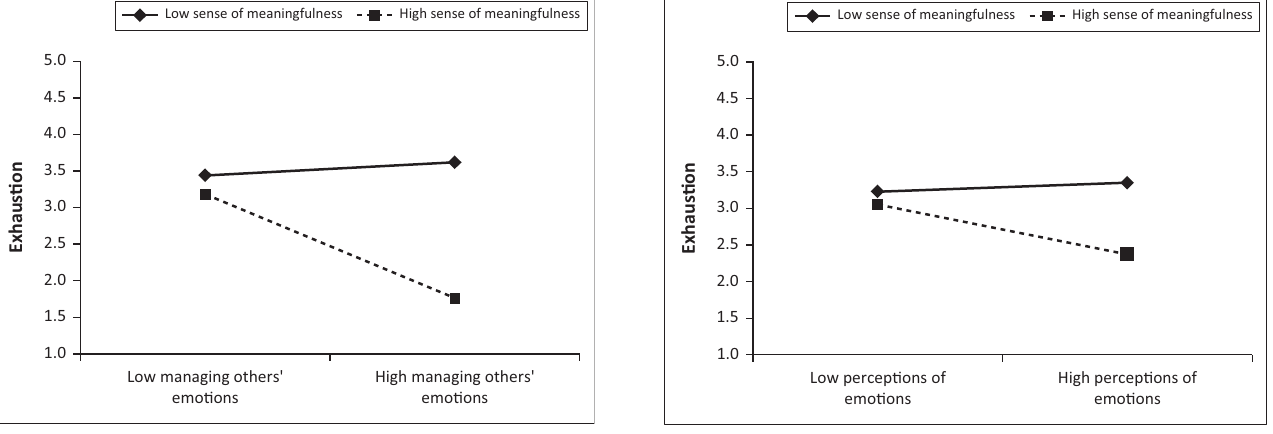
FIGURE 1: Interaction effect (managing others’ emotions x sense of meaningfulness) in predicting exhaustion.